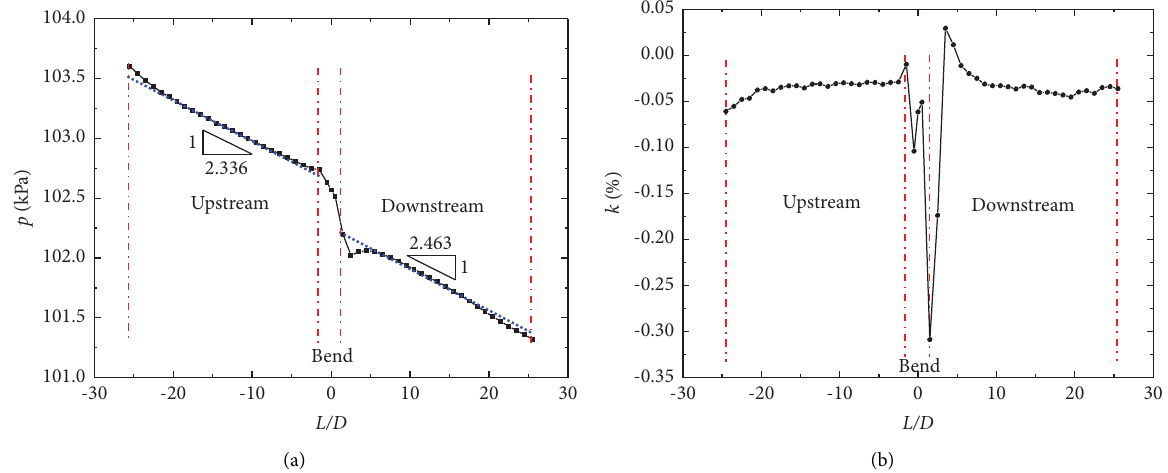
Figure 5: Pressure distribution characteristic curve along the horizontal L-shaped pipe: (a) Pressure distribution curves along the pipe from the inlet to the outlet, (b) Te change rate of pressure along the pipe from the inlet to the